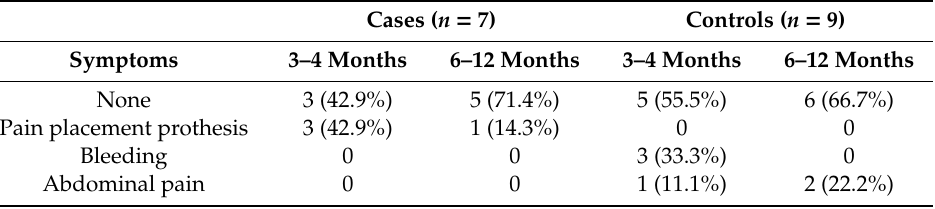
Table 2. Symptoms experienced by the case and control groups.